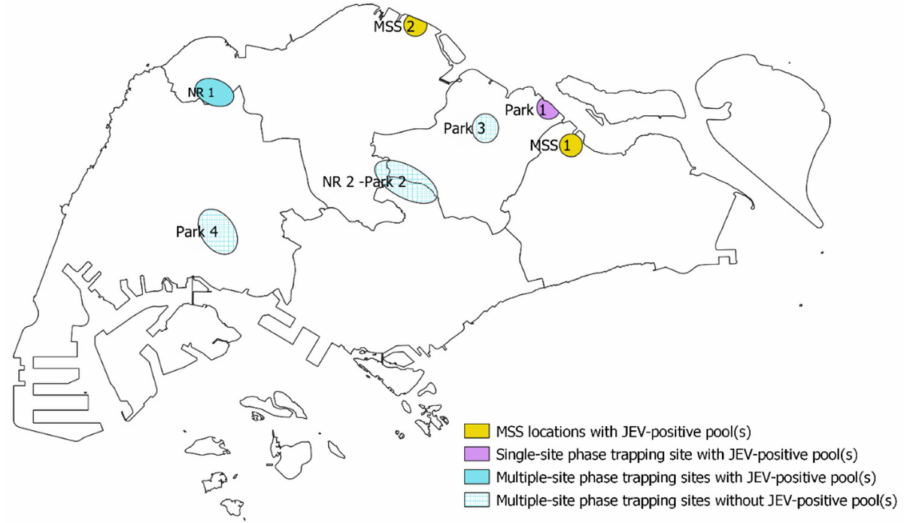
Figure 1. Locations of the five sites used in JEV entomological surveillance in this study, as well as the two locations where JEV was detected in mosquitoes that were obtained from MSS. The single-site study site is in purple and the multi-site study sites are in light blue. MSS locations are in yellow. The solid shapes indicate areas where JEV-positive pools were observed, while the hatched shapes indicate areas where JEV-positive pools were not observed. See Figure S1 for the approximate locations where ardeid birds and wild boars were sighted in